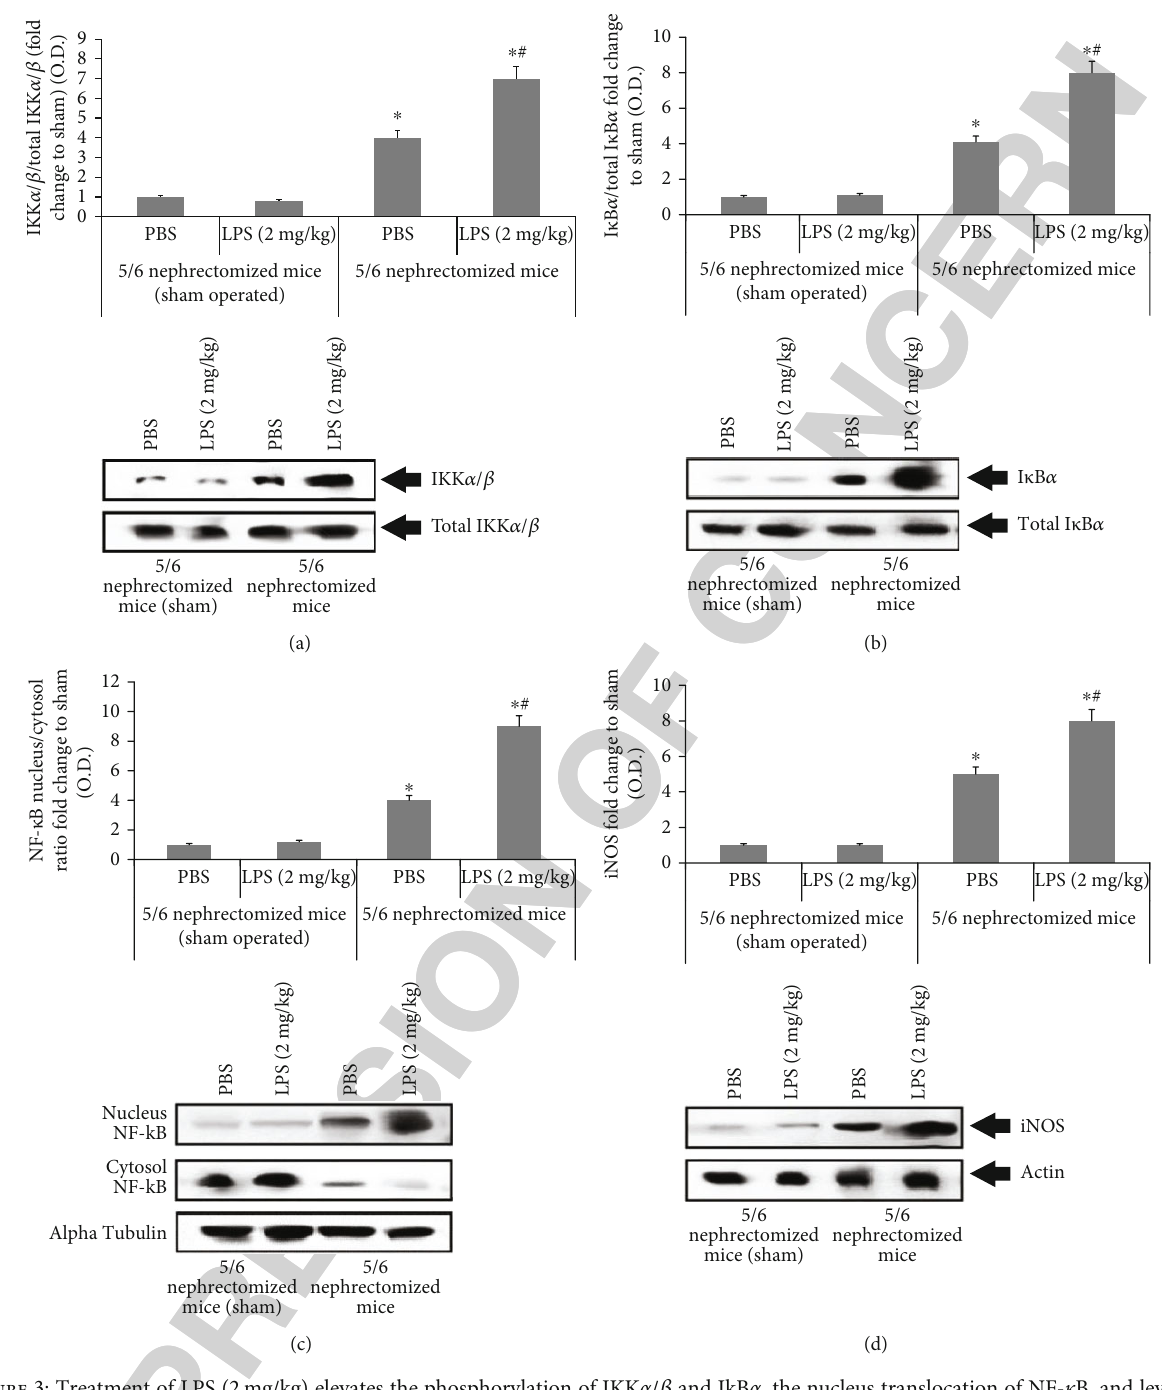
Figure 3: Treatment of LPS (2 mg/kg) elevates the phosphorylation of IKK α / β and IkB α , the nucleus translocation of NF- κ B, and levels of iNOS. 5/6 nephrectomized sham mice or 5/6 nephrectomized mice were given either LPS (2 mg/kg) or vehicle (PBS) via intraperitoneal route. The signaling e ff ects on cardiac tissue were evaluated after 18 hours. The optical density was assessed. (a) Optical density of phosphorylated IKK α / β against total IKK α / β levels normalized against corresponding sham band. (b) Optical density of phosphorylated IkB α against total IkB α levels normalized against corresponding sham band. (c) Levels of NF- κ B in nuclear and cytosolic fractions presented as nucleus/cytosol ratio; the results were normalized against corresponding sham band. (d) Levels of iNOS normalized against actin as loading control. All the analysis was performed in triplicate. ∗ P < 0 : 05 compared to 5/6 nephrectomized sham mice with described treatment; # P < 0 : 05 compared to the corresponding PBS